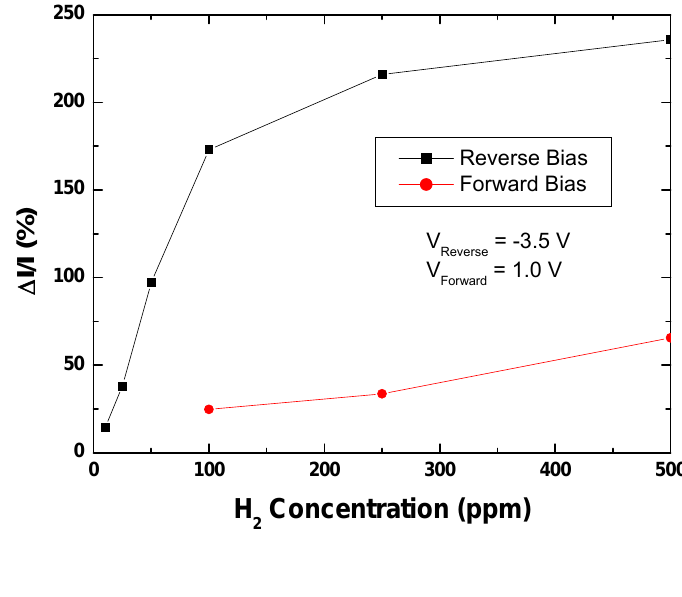
Figure 13. Percentage change in current as a function of hydrogen concentration under both forward and reverse